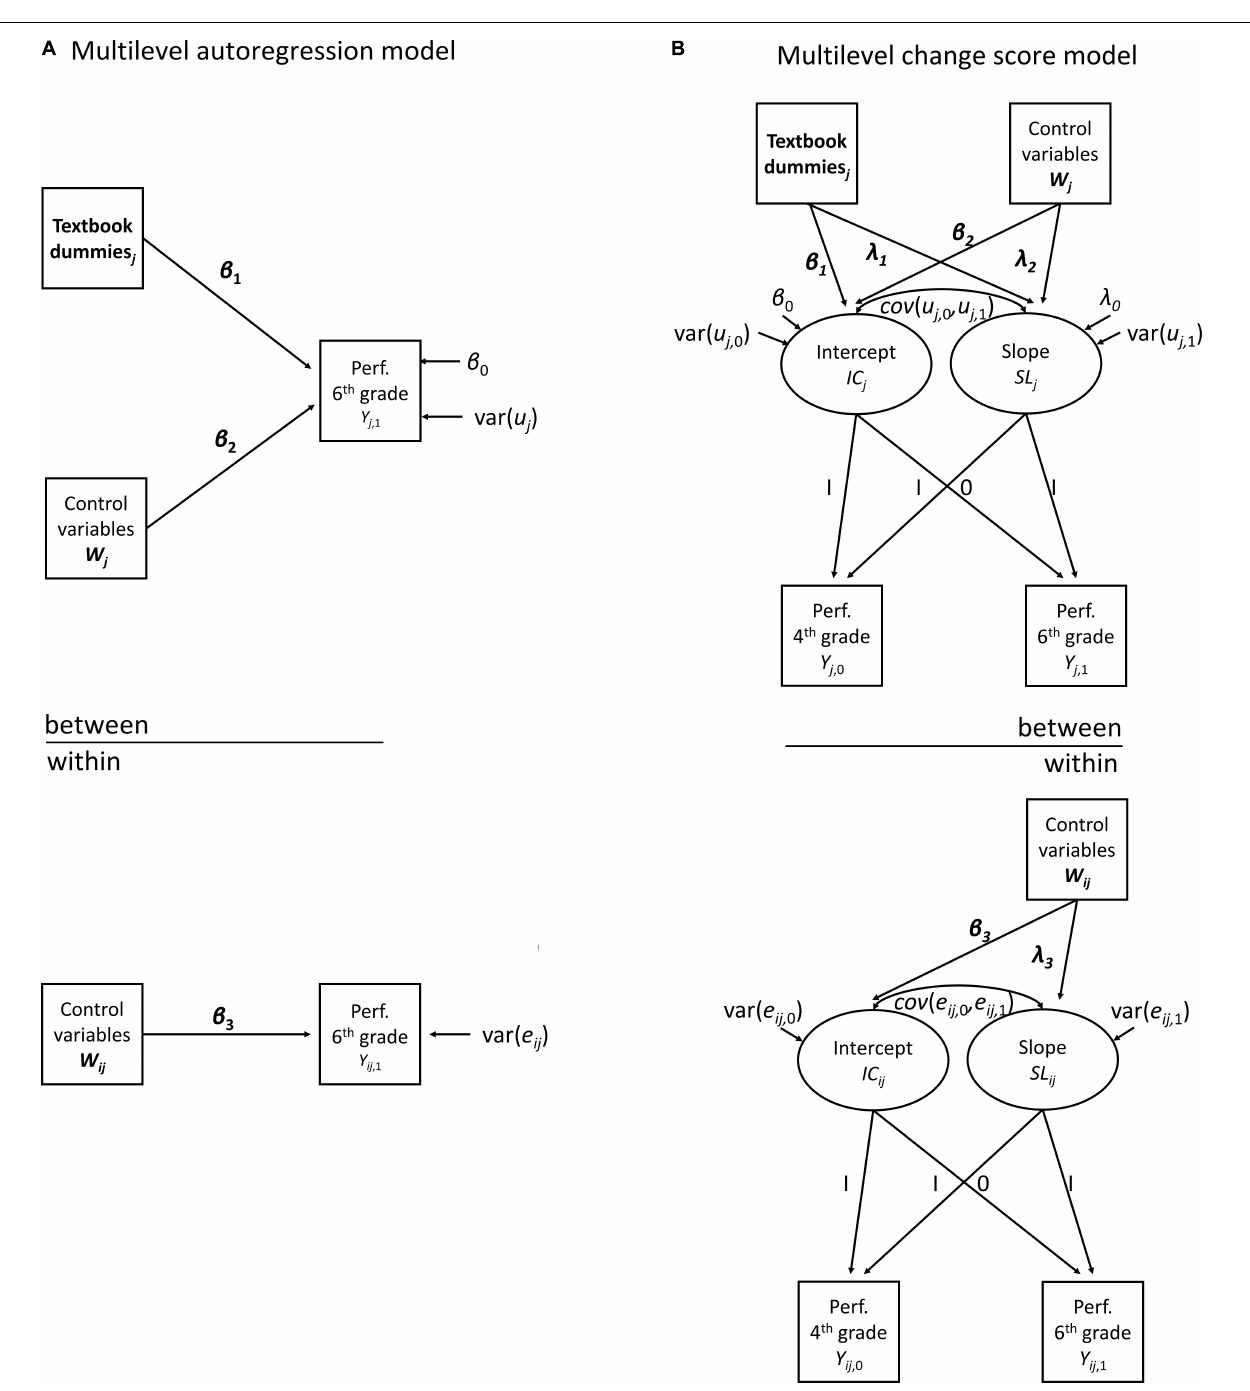
While the autoregression model (or residualized change score model) has been the standard approach to assess change in average test scores between two time points, recently there has been a renewed interest in the usage of change score